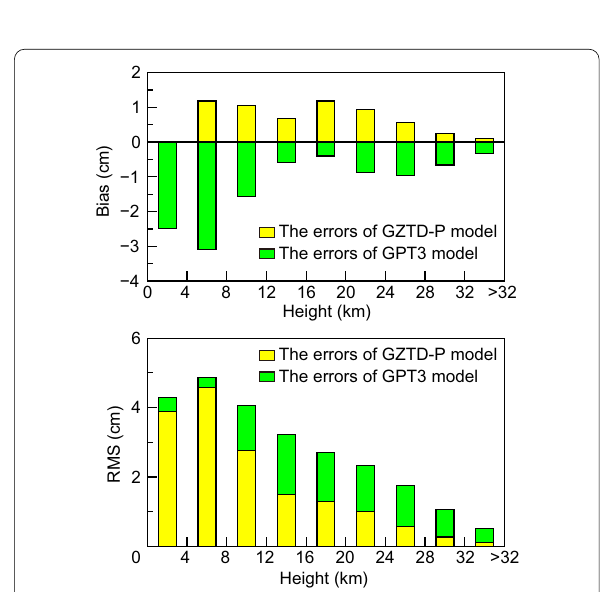
The errors of GZTD-P model The errors of GPT3 model